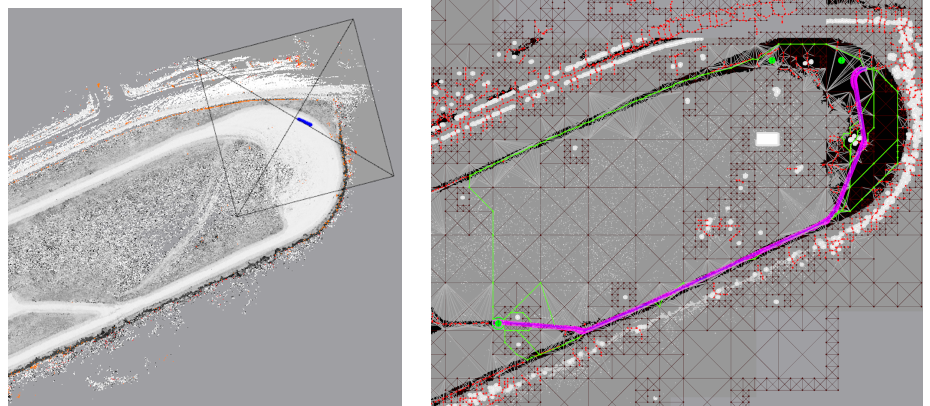
Figure 12. The persistent map may be used for path planning outside the current sensor range of the vehicle. On the ( left ), a portion of the persistent map seen in Figure 3, with the approximate current sensor footprint shown. On the ( right ), the averick Planner [34] is used to plan a path on this map. The planned path is visible in purple. The green and red lines show details of the path planning data